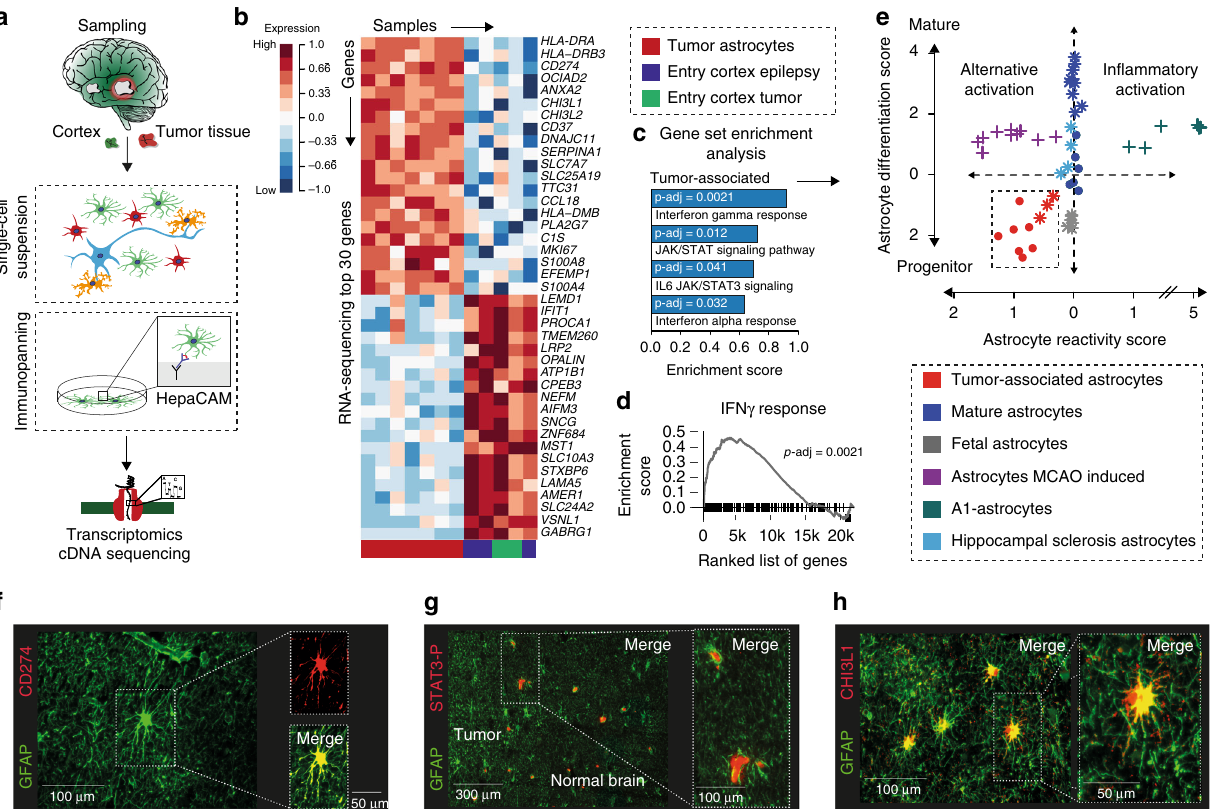
Fig. 1 Puri fi cation and transcriptional pro fi ling of tumor-associates astrocytes. a Illustration of the work fl ow. Cortex specimens from epilepsy patients ( n = 3), entry cortex from glioblastoma patients ( n = 2) and glioblastoma specimens ( n = 7) were collected, followed by puri fi cation of astrocytes using immunopanning. RNA was analyzed by cDNA sequencing. b AutoPipe unsupervised cluster and heatmap of 30 most representative genes of astrocytes derived from healthy cortex and tumor specimens. c Gene set enrichment analysis (GSEA) highlights an increased response to cytokines, and JAK/STAT signaling in tumor-associated astrocytes. Exact values are given in the source fi le. d Gene set enrichment plot of ranked gene expression indicate the enrichment of the IFN γ response in tumor associated astrocytes. e Two-dimensional scatterplot of astrocytic differentiation and reactivity reveals a shift in the tumor-associated astrocytes towards the progenitor phenotype and alternative reactivity. Each individual dot represents a transcriptome pro fi le. Round dots mark the expressions analyses generated in this study, other data are marked with stars (Zamanian et al., 2012) 17 , as well as crosses (Zhang et al., 2016) 13 . Colors indicate the source of astrocytes as illustrated below. List of selected genes is given in the source fi le. f – h Immunostaining of tumor- associated astrocytes localized at the glial scar in the in fi ltrating region. GFAP + -astrocytes were marked by CD276 expression, STAT3 phosphorylation